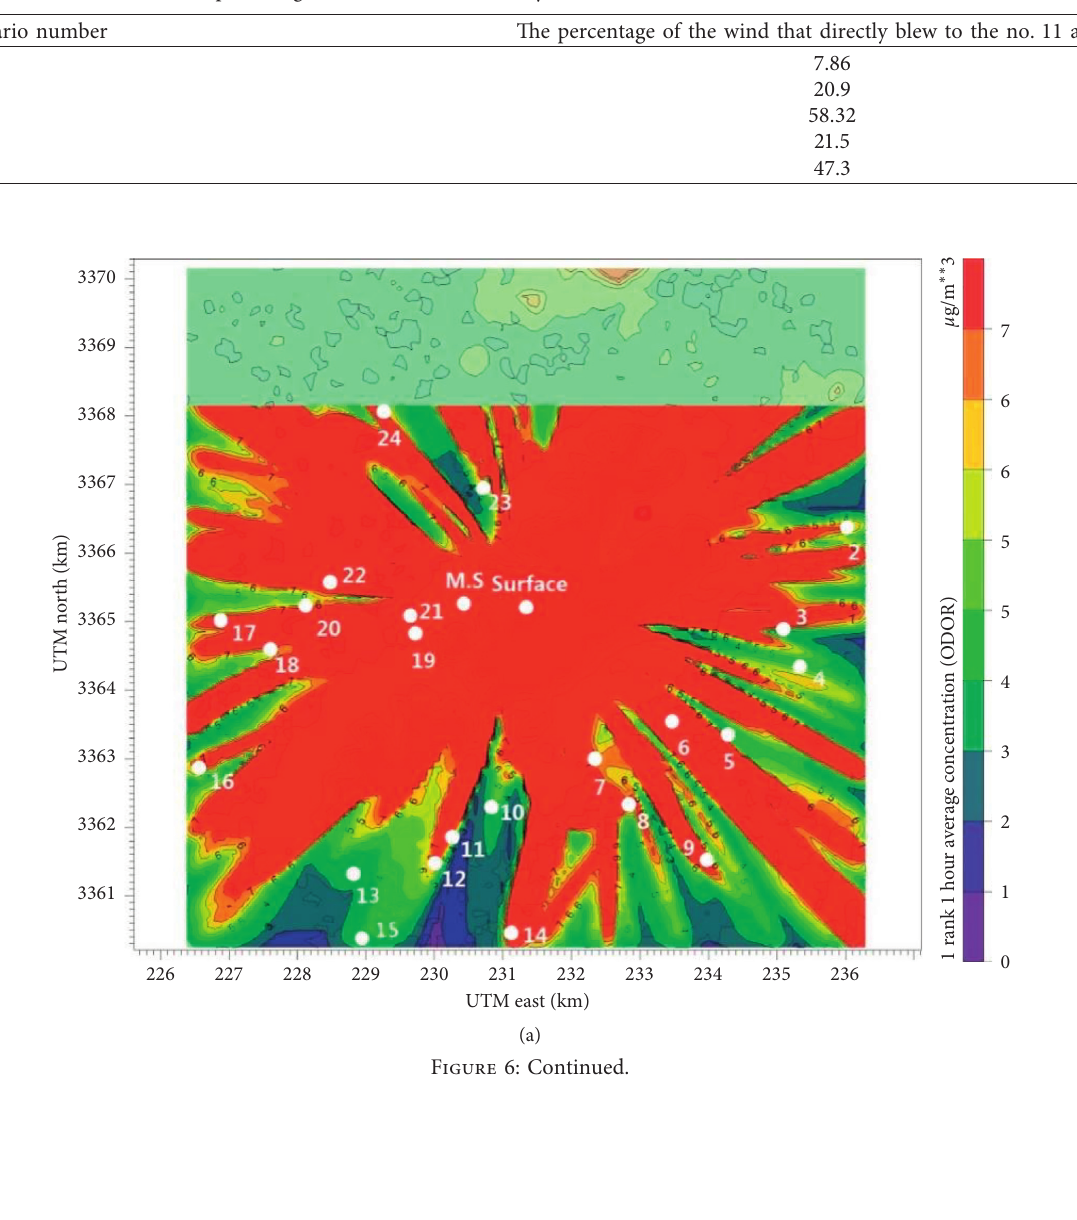
Table 2: The percentage of the wind that directly blew to the no. 11 area in different